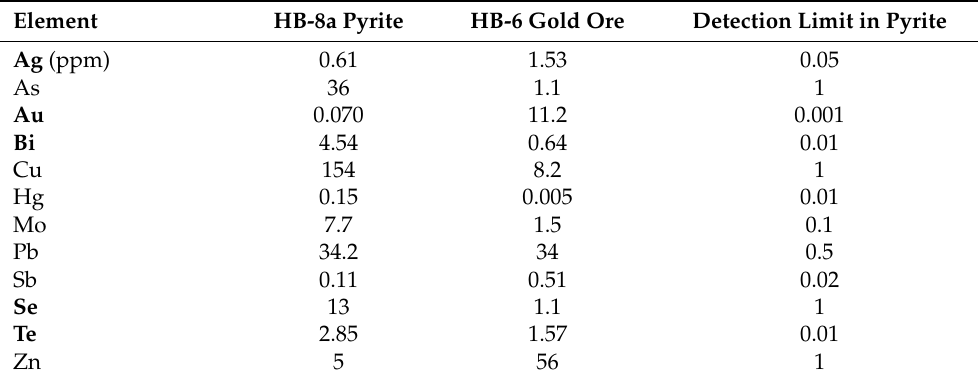
Table 1. Trace element analyses of pyrite from the Albite-Actinolite Porphyry and of gold ore from the boudinaged Main Porphyry, New Celebration